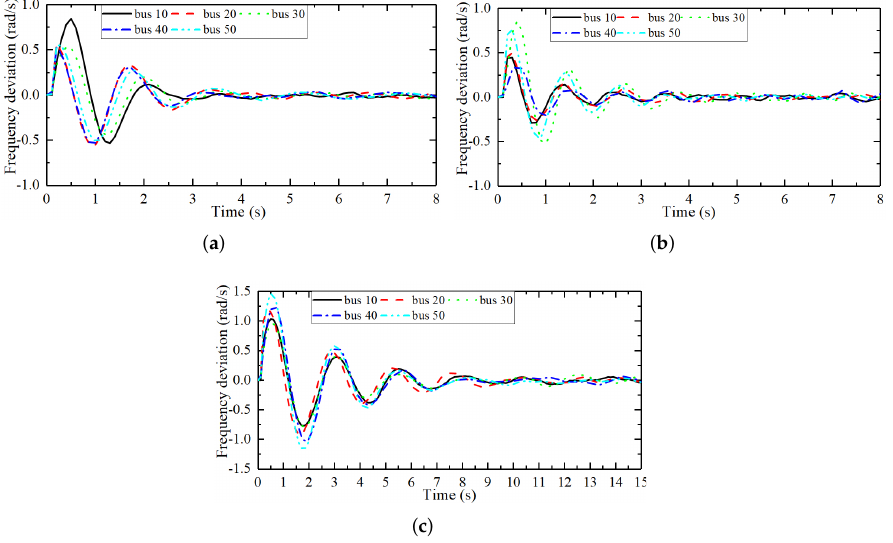
Figure 14. Frequency deviation curve of the IEEE 57 bus testing system under three different methods, η ji = 0.1. ( a ) Based on convex neural networks. ( b ) Based on RBF neural networks. ( c ) Based on RNN neural